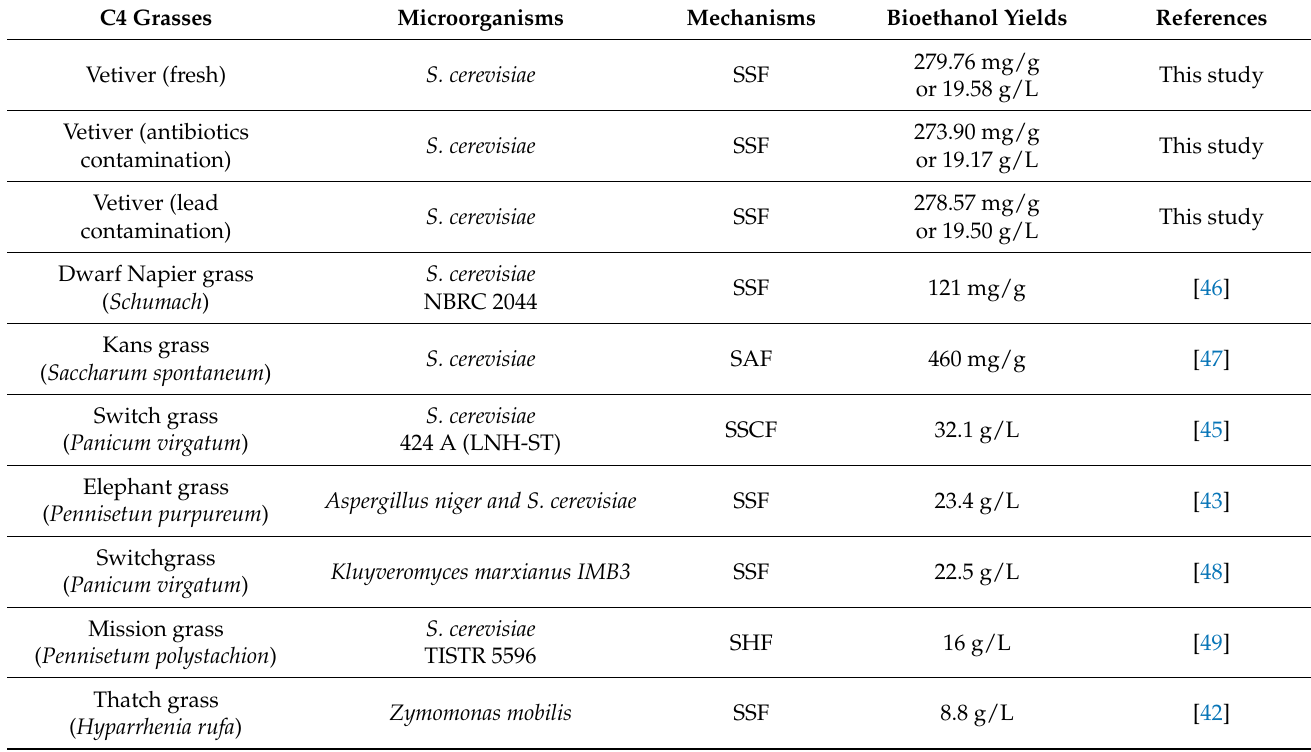
Table 2. Comparison of bioethanol yield of VG and other C4 grasses previously reported.